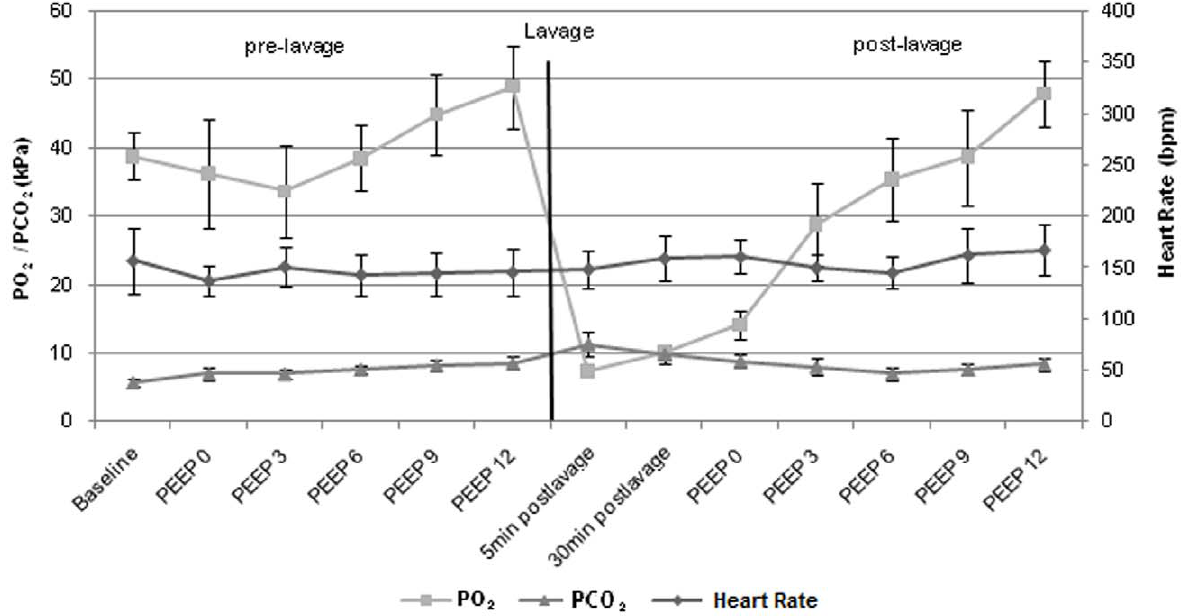
Figure 2. Blood Gases and Heart Rate. Shown are mean (SD) values of blood gases and heart rate for n=5 animals. Blood gas analyses were performed after measurements at one PEEP level before changing to the next PEEP level.